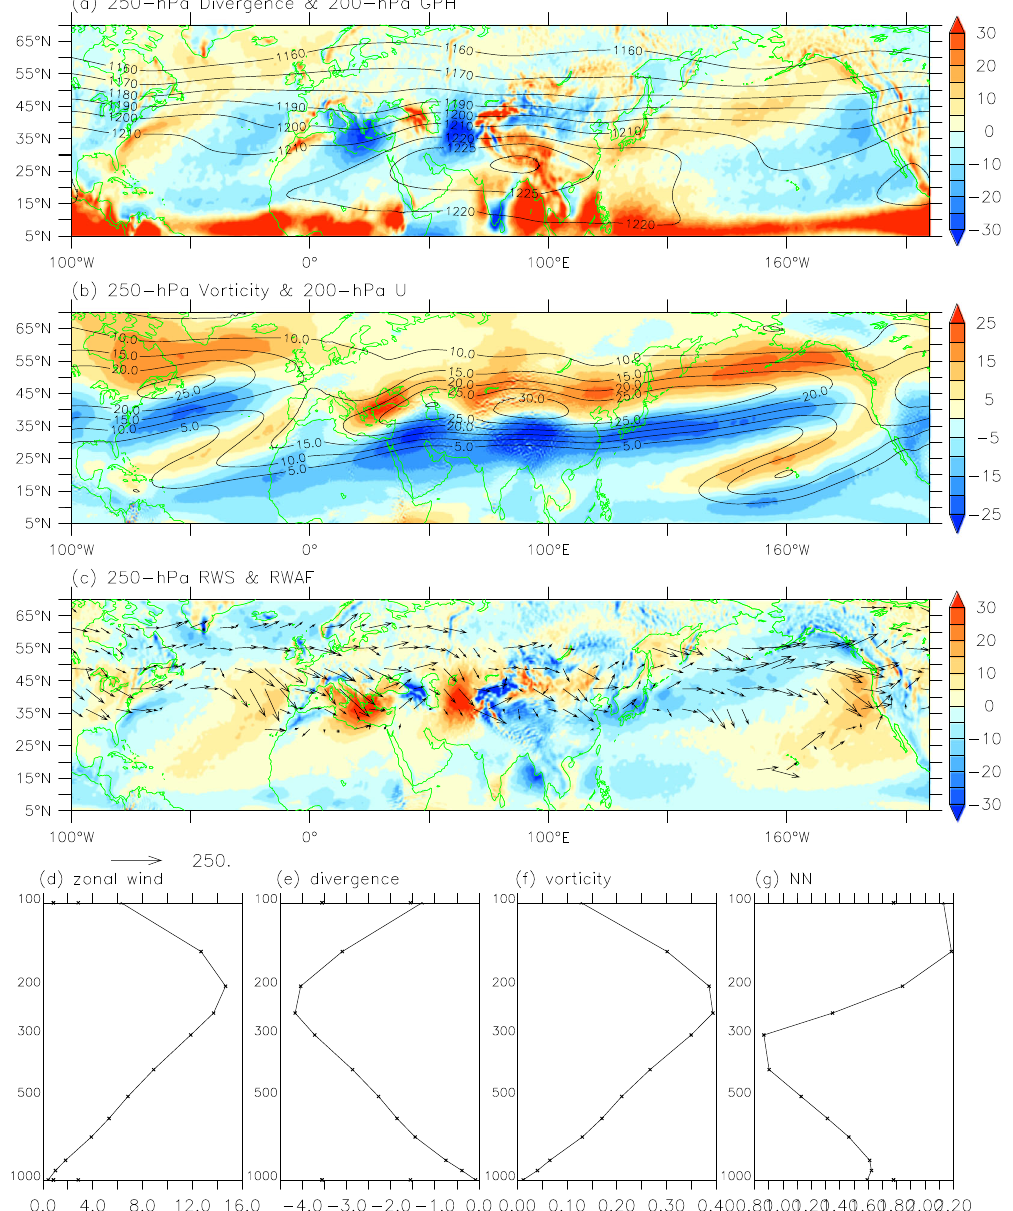
Fig. 1 Climatology. Spatial pattern of seasonal (JJAS) mean climatology (period: 1979 – 2019) of a 250-hPa Divergence (shaded) and 200-hPa GPH (black contours), b 250-hPa Vorticity (shaded) and 200-hPa Zonal Wind >5 ms − 1 (black contours), c 250-hPa Rossby wave source (shaded) and the horizontal component of Rossby wave fl ux (black arrows). Vertical pro fi les of climatological-mean d zonal wind, e divergence, f vorticity and g Brunt – Väisälä frequency (NN) for the mid-latitude area-averaged region (100°W-110°E,